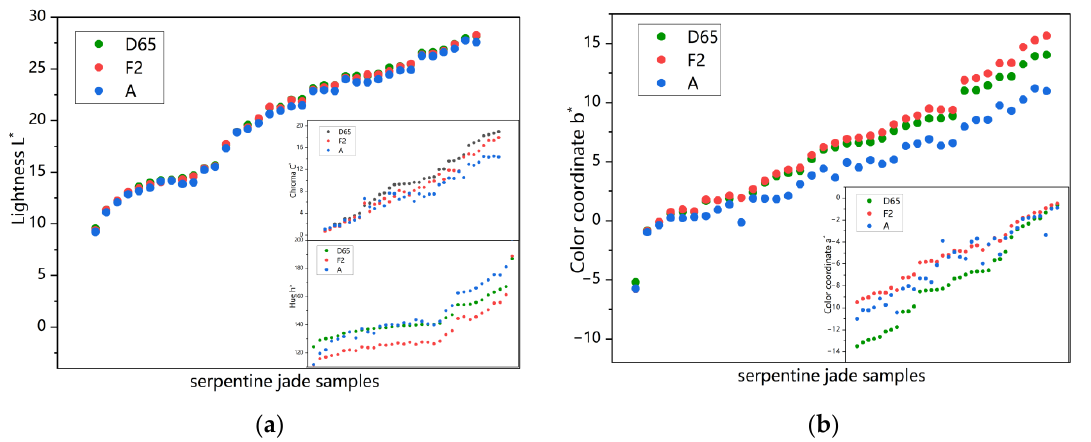
Figure 4. ( a ) The lightness L*, chroma C*, and hue angle h° under three light sources; ( b ) the color coordinates a* and b* under three light sources.